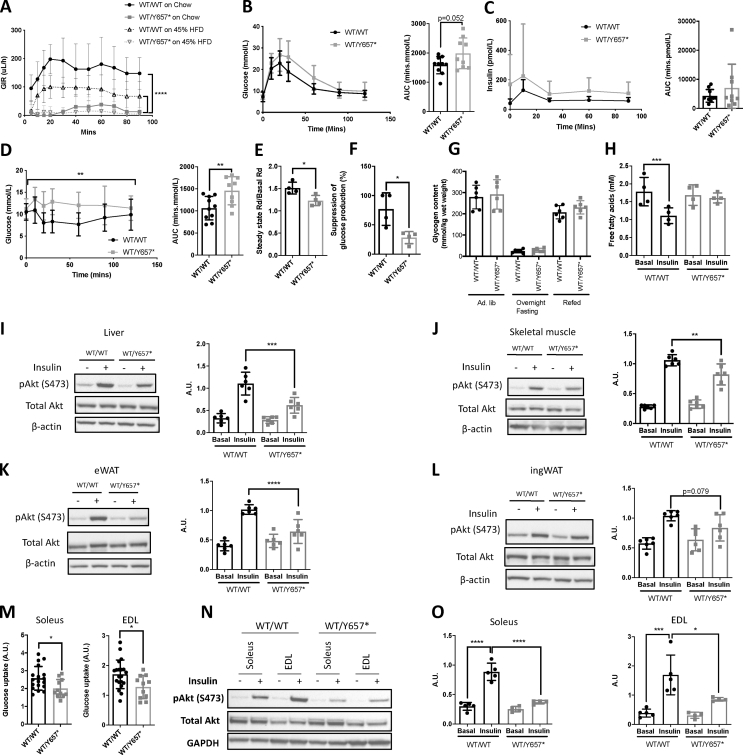
Pik3r1WT/Y657∗ mice show systemic and tissue-level insulin resistance. (A) Glucose infusion rates during hyperinsulinemic euglycemic clamping of Pik3r1WT/WT (WT/WT) and Pik3r1WT/Y657∗ (WT/Y657∗) mice on chow (n = 4 and 4) or 45% fat diet (n = 10 and 11) at 16 weeks old. (B) Oral glucose tolerance test (OGTT) and corresponding comparison of areas under the curves (AUC) of Pik3r1WT/WT and Pik3r1WT/Y657∗ mice on chow at 12 weeks old (n = 10 and 9). (C) Insulin concentrations and AUC for the same OGTT as in (B). (D) Insulin tolerance test and AUC comparison for the same mice 1 week later. (E) Glucose disposal and (F) suppression of hepatic glucose output by insulin during hyperinsulinemic euglycemic clamping of Pik3r1WT/WT and Pik3r1WT/Y657∗ mice on chow at 18 weeks old (both n = 4). (G) Glycogen content of livers during a fasting–refeeding cycle in chow fed animals at 16 weeks old (both n = 6). (H) Plasma non-esterified free fatty acid concentrations during hyperinsulinemic euglycemic clamping (both genotypes n = 4). (I)–(L) Representative images of immunoblots and corresponding quantifications of tissue lysates from mice injected intraperitoneally with 2 U/kg insulin 10 min prior to sacrifice, showing pAktSer473, total Akt and their ratio: (I) Liver, (J) Skeletal muscle (K) eWAT, (L) ingWAT (n = 6 per genotype and condition). (M) Insulin-induced fold increase of glucose uptake into ex vivo incubated soleus (n = 18 for Pik3r1WT/WT, n = 11 for Pik3r1WT/Y657∗) and Extensor Digitorum Longus (EDL) (n = 20 and 11). (N) Representative immunoblots of Soleus and EDL lysates from the same paradigm as in (M). (O) Quantification of pAktSer473 to total Akt ratios from soleus and EDL immunoblots (n = 5 and 4 for both). Data are from male mice. Quantitative data are presented as mean ± SD. ∗ = p < 0.05, ∗∗ = p < 0.01, ∗∗∗ = p < 0.001 and ∗∗∗∗ = p < 0.0001.